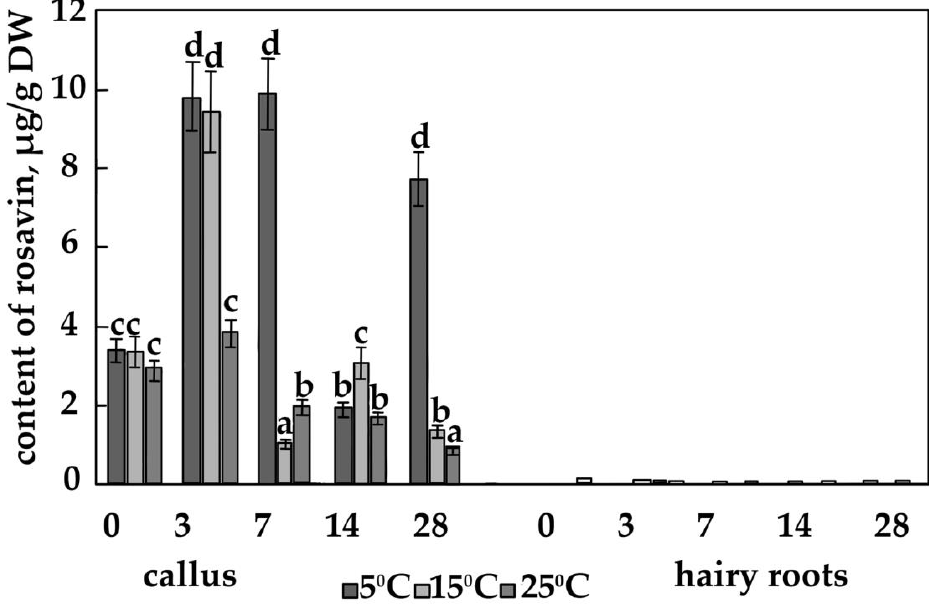
Figure 4. Rosavin content in calli and hairy roots of R. quadrifida .